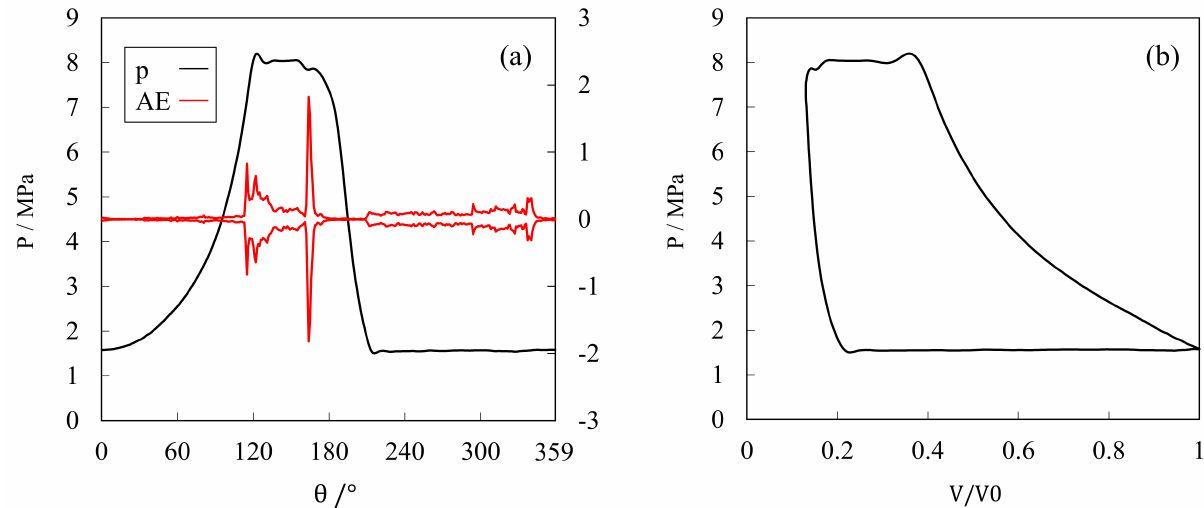
Figure 23. p − θ diagram integrated with AE signal ( a ) and p − V diagram ( b ) of the repaired valve in the hydraulically driven piston